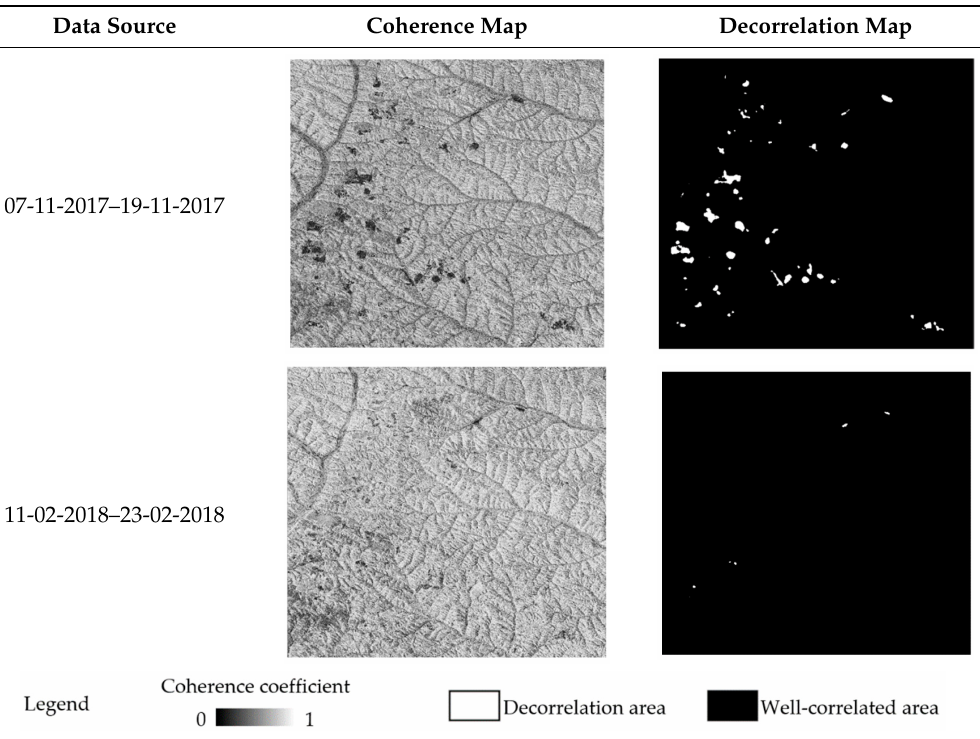
Table 5. Comparison